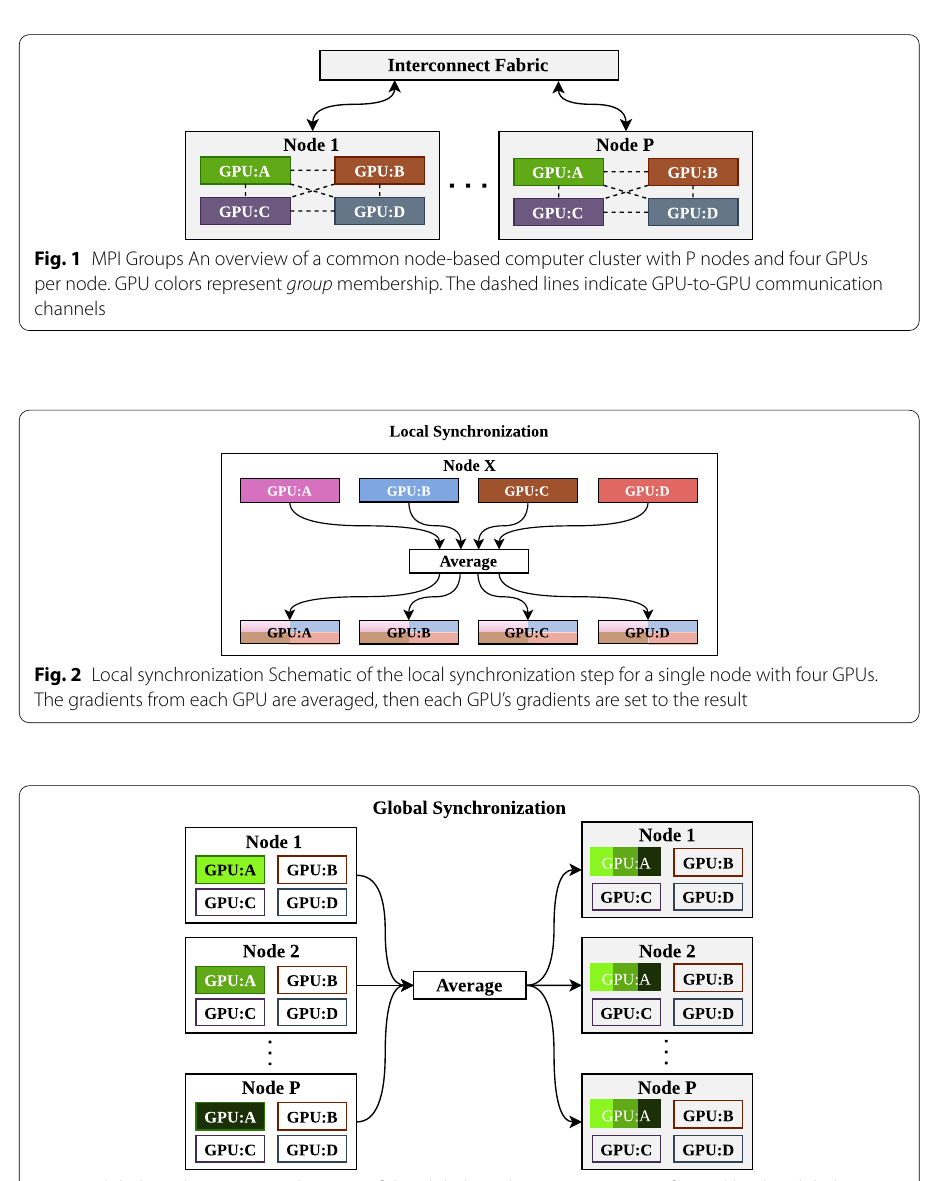
Fig. 3 Global synchronization Schematic of the global synchronization step performed by the global communication group consisting of GPU:A on each node. The network parameters are averaged by each GPU in the group , and the network parameters of each group member are set to the